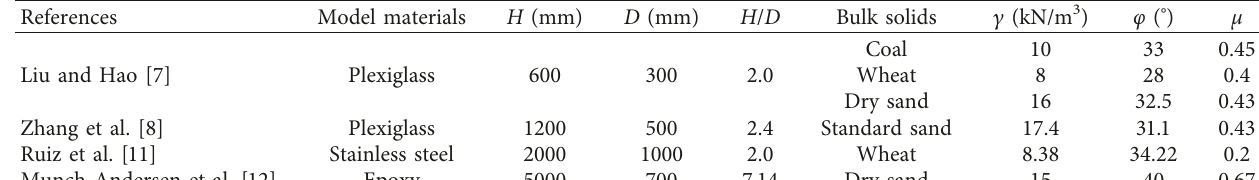
Table 1: Geometrical data and material properties of deep